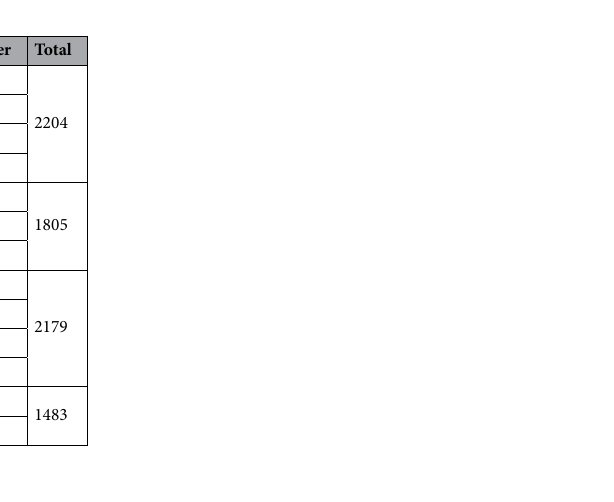
Figure 9. Examples of garbage images in the dataset: ( a ) apple core, ( b ) button battery, ( c ) book, ( d ) capsule, ( e ) pencil, ( f ) toothbrush, ( g ) vegetable leaf, ( h ) watermelon peel.